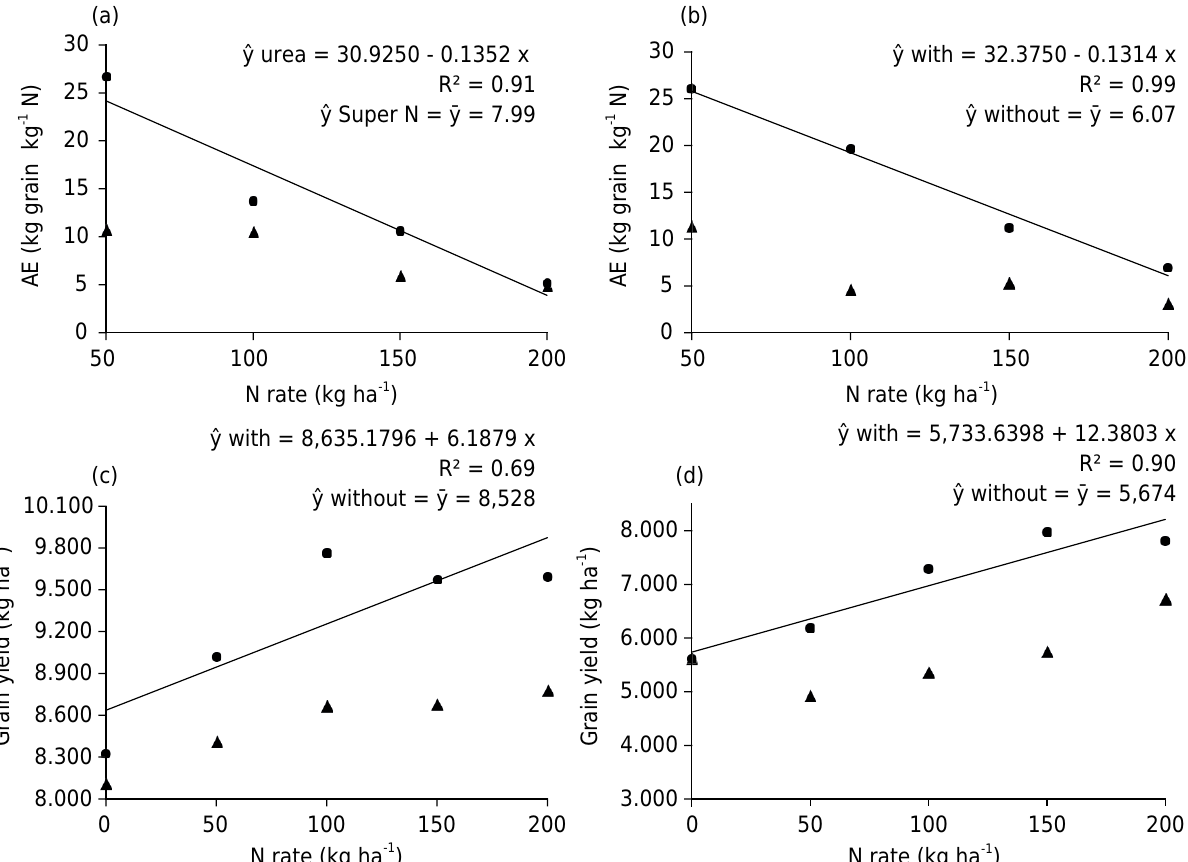
Figure 4. Agronomic efficiency (EA) of corn in 2013/14 (a) and 2014/15 (b) in regard to rate and source of nitrogen (N) interaction within inoculation, and corn grain yield in 2013/14 (c) and 2014/15 (d) in regard to rate of nitrogen (N) interaction within